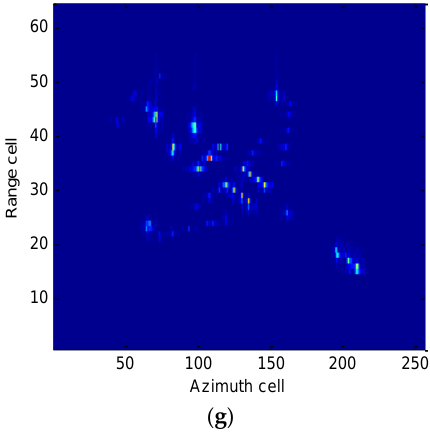
Figure 14. Inverse synthetic aperture radar ( ISAR) imaging results: ( a ) RD algorithm, ( b ) STFT algorithm, ( c ) WVD, ( d ) SPWVD, ( e ) FRFT, ( f ) No-CLEAN technique and ( g ) ICPF-FRFT algorithm. The simulated echo pulses of Boeing-727 shown in Figure 14 are available online at http://www.mdpi.com/2072- 4292/10/4/593/s1. Table 3. Comparison results of the Boeing-727 images.